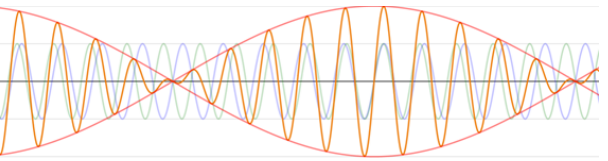
Figure 1. The beating pattern of the superposition of two sine waves with similar frequencies ( f 1 and f 2 ) (blue and green) nonlinearly causes an interference frequency sinusoid at the sum frequency ( f 1 + f 2 )/2 (orange) and another sinusoid, which is the envelope curve of ( f 1 + f 2 )/2 modulated at the difference frequency ( f 1 − f 2 ) (For those who wonder why the difference frequency is not given as ( f 1 − f 2 )/2: Since for the audible envelope beating, it is irrelevant whether amplitude develops above or below the baseline, the frequency of the loudness fluctuation is effectively doubled, making the audible beat frequency f beat = | f 1 − f 2 |). A Fourier transform of the signal contains only f 1 and f 2 (blue and green), no new frequencies. Picture taken from [7].